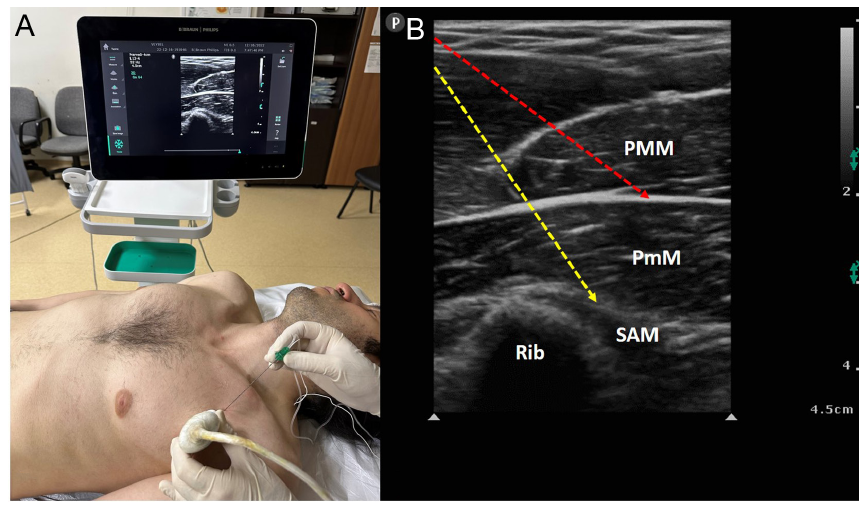
Figure 5. A, B. (A) Patient and ultrasound probe position for interpectoral plane block and pectoserratus plane block procedure. (B) Sonographic anatomy of the block. PMM, pectoralis major muscle; PmM, pectoralis minor muscle; SAM, serratus anterior muscle; red arrow, needle direction for interpectoral plane block; yellow arrow, needle direction for pectoserratus plane block